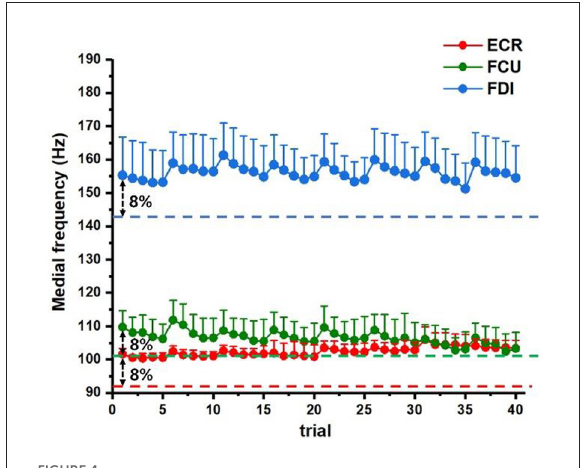
FIGURE4 The sEMG signals were used for fatigue status monitoring. The averaged MF statistics of 8 days were summarized above for target muscles (ECR: red, FCU: green, and FDI: blue) during training. The dashed lines correspond to the preset fatigue threshold (8% decline level of the averaged MF of first trial according to previous references).